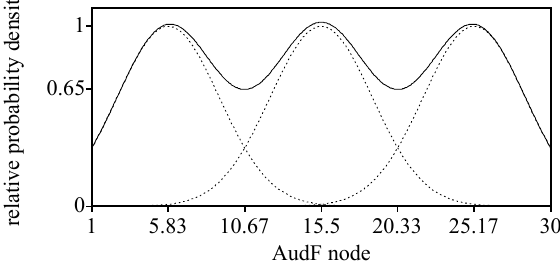
A CoG distribution in a language with three sibilant